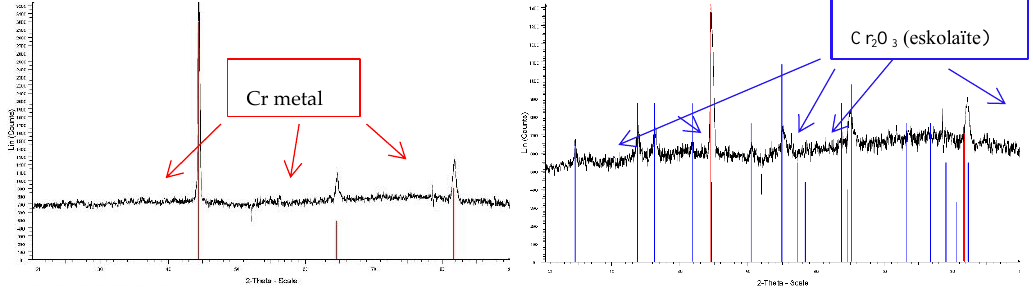
Figure 16. XRD diffractograms of pellet before and after sintering at 800 °C .